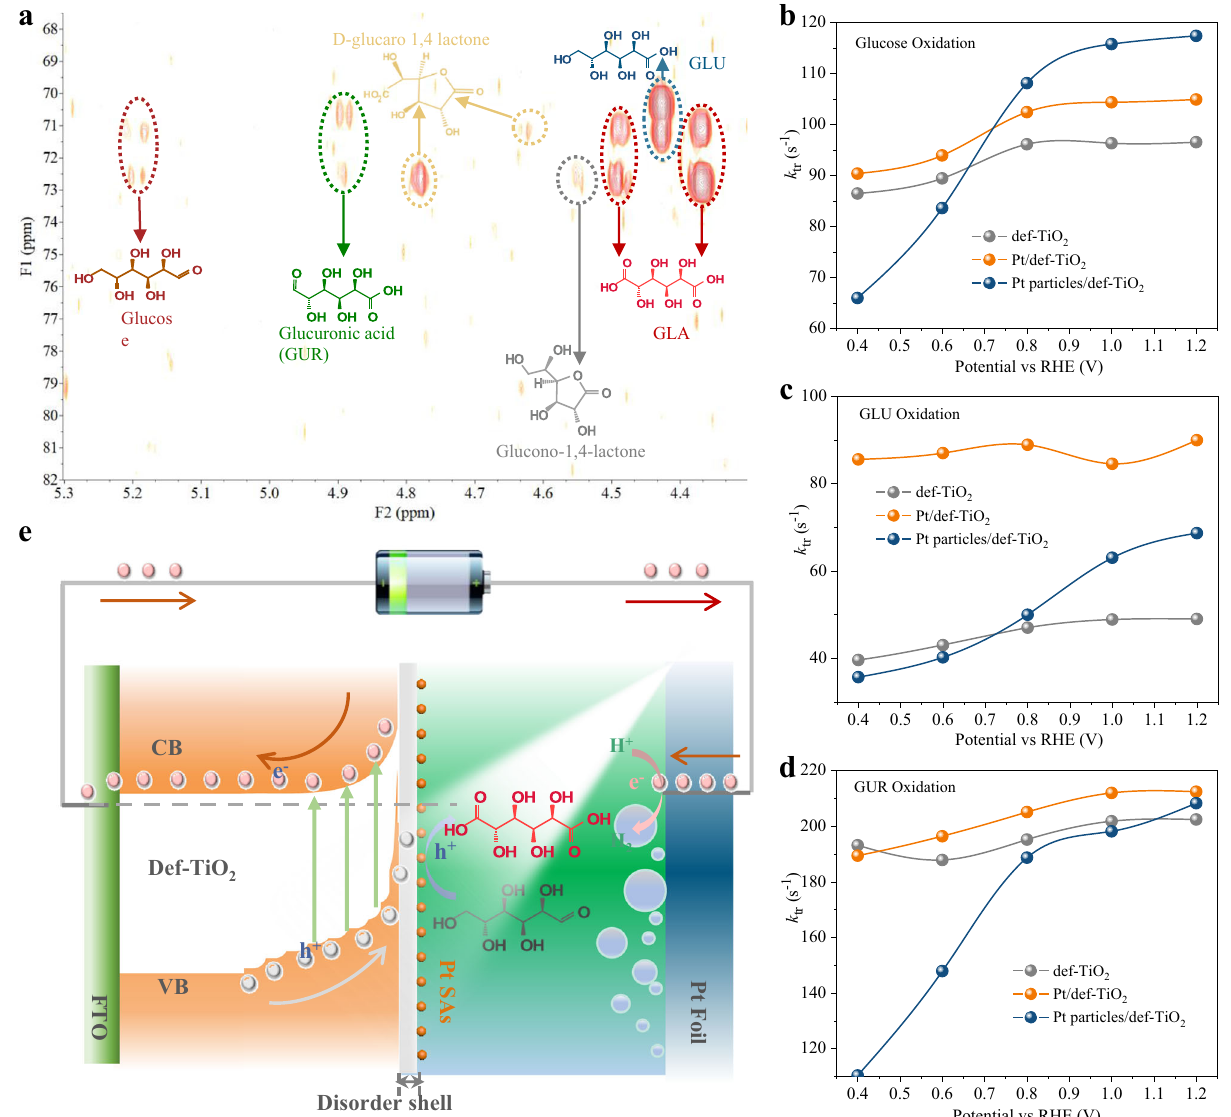
Fig. 5 | The kinetics ofPEC oxidationofglucose. a 13 C − 1 H HMBCNMR spectrum of the products after 3h oxidation over the Pt/def-TiO 2 photoanode under AM 1.5 simulated sunlight irradiation. Conditions: 1M KOH deuteroxide solution with 10mMglucose,at0.6V RHE .The k t for( b )GLU,( c )GLA,and( d )GURoxidationover